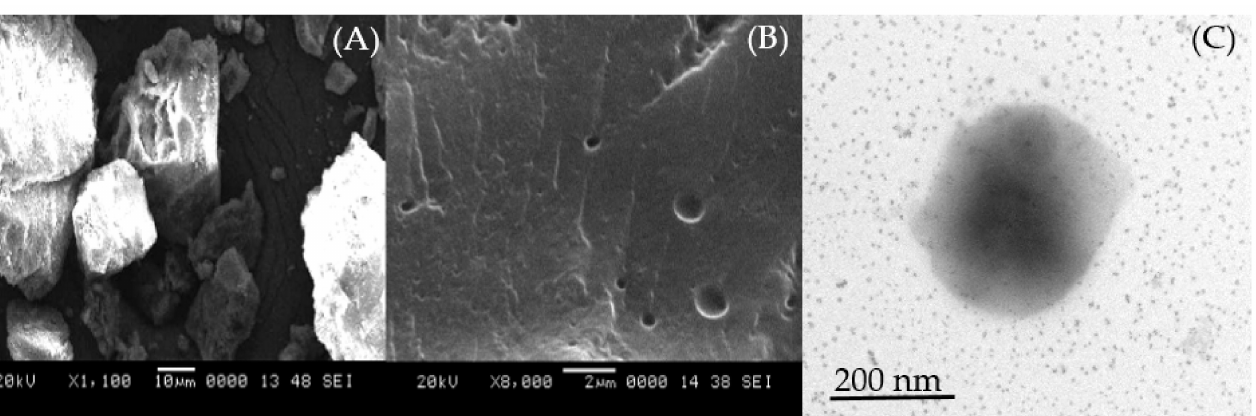
Figure 2. SEM image of ( A ) silymarin and ( B ) optimized silymarin phytosomes. ( C ) TEM image of optimized silymarin